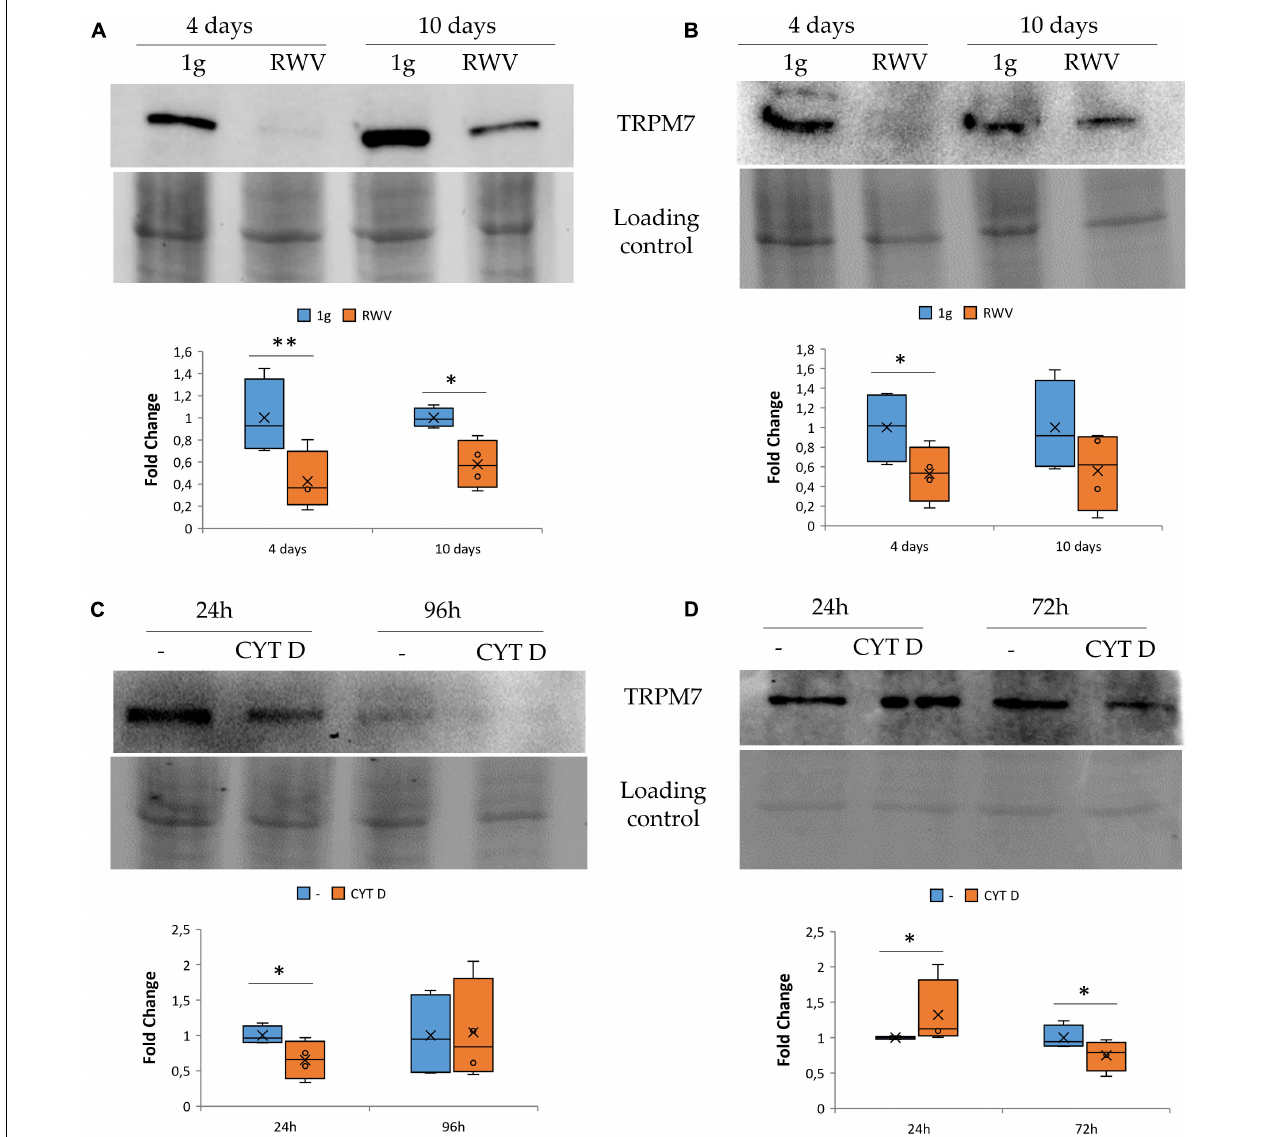
FIGURE 2 | The effect of microgravity and cytoskeletal disruption in 1g on transient receptor potential melastatin 7 (TRPM7) in human endothelial cell from umbilical vein (HUVEC) and human dermal microvascular endothelial cell (HDMEC) the levels of TRPM7 were analyzed by western blot in HUVEC (A,C) and HDMEC (B,D) exposed to simulated microgravity [panels (A,B) , respectively] or to CYT D in 1g condition [panels (C,D) respectively]. Control loading was used to normalize, and the densitometric analysis is reported. * P < 0.05 and ** P <